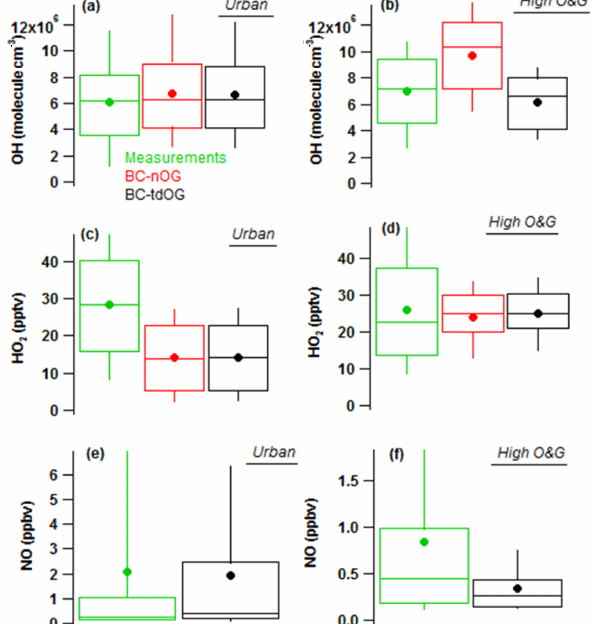
Figure 7. Comparison of the measured and WRF-Chem-predicted (no O&G and top-down O&G emission scenarios) amounts of OH ( a and b ), HO 2 ( c and d ), and NO in urban- and high-O&G- influenced plumes. Box and whisker plots depict the 10th, 25th, 50th, 75th, and 90th percentiles. Mean values are shown in circles.